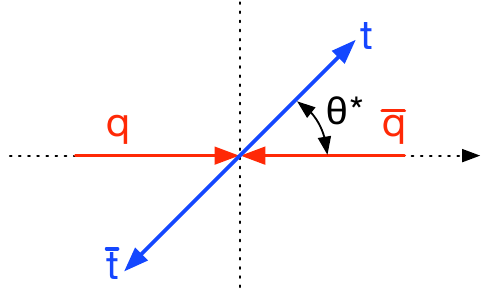
Figure 2 . Production angle (cid:18) (cid:3) in a qq ! tt event de(cid:12)ned in the tt center-of-mass